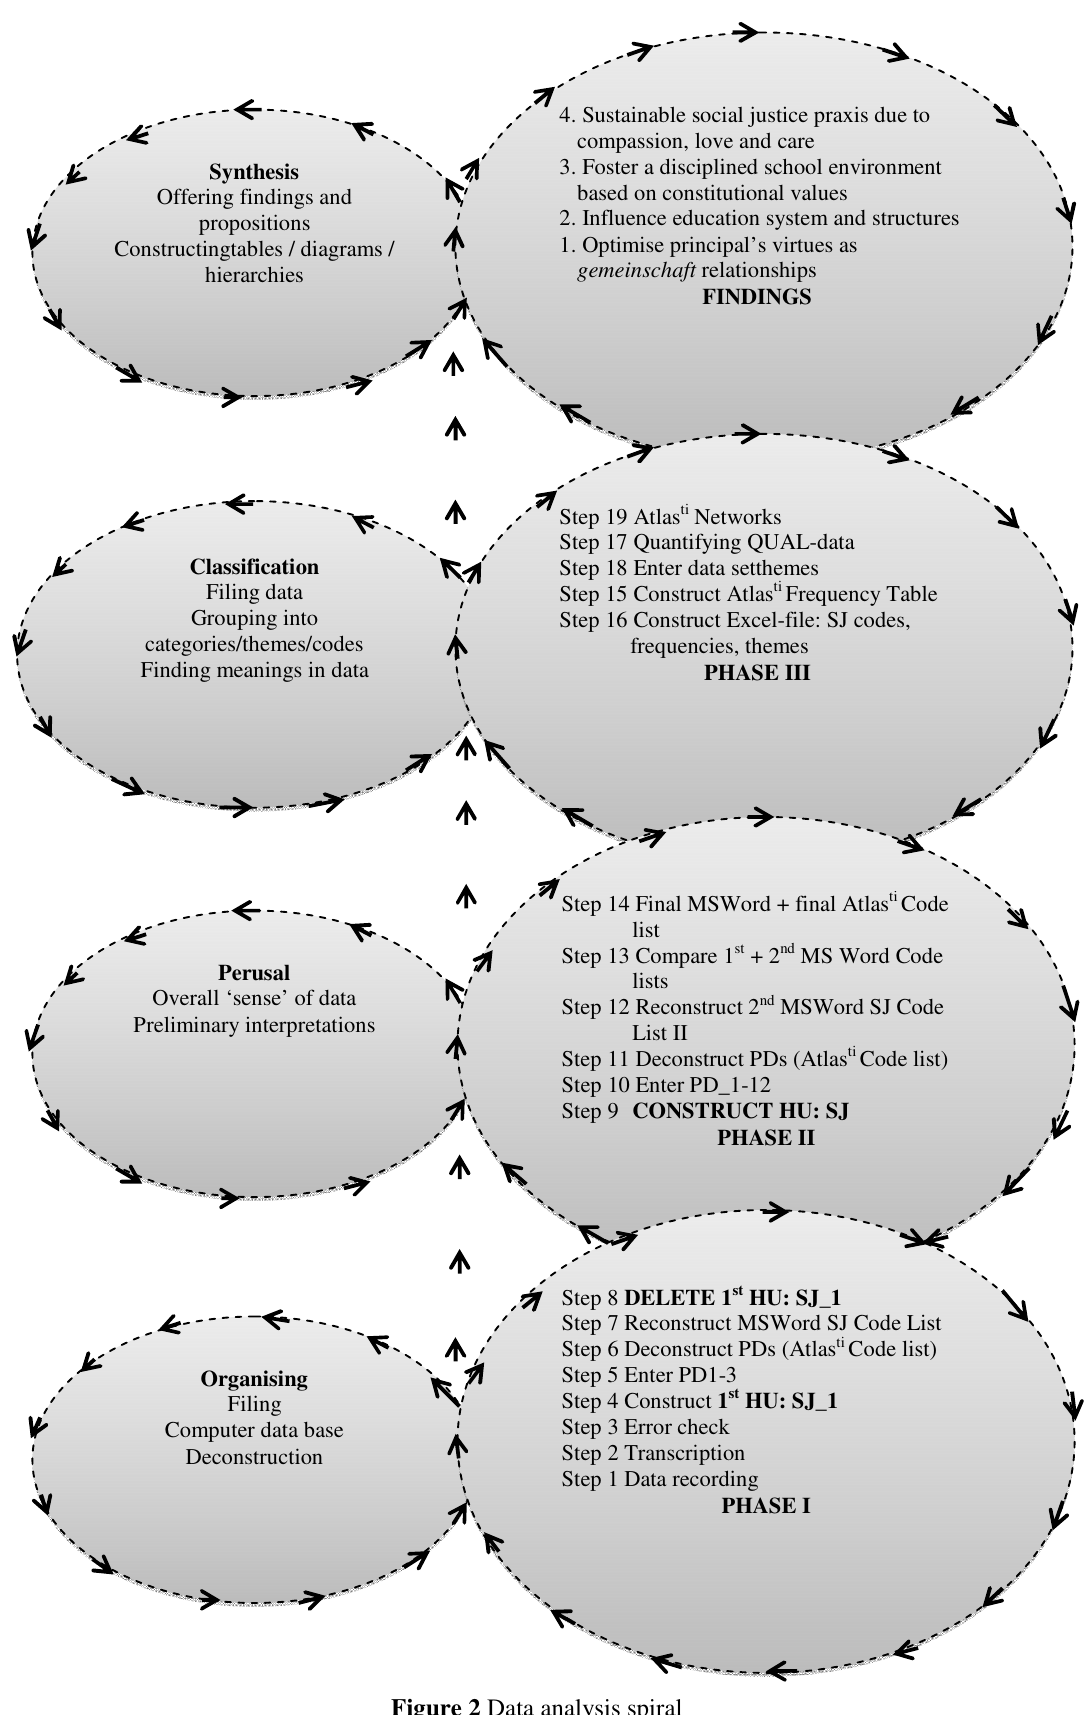
Figure 2 Data analysis